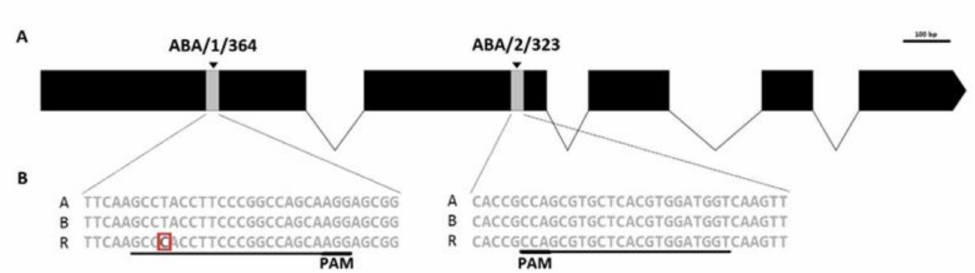
Figure 1. ( A ) Schematic diagram of target ABA8 (cid:48) OH1 regions used for selection of two gRNAs. Black boxes indicate exons, black lines indicate introns, gray boxes represent the regions in exon 1 and exon 2 designated for Cas9/gRNA-induced mutagenesis. ( B ) Detailed sequence context of target motifs (underlined, with PAM indicated) on A, B, and R of triticale sub-genomes. Notably, one SNP is present in the target motif ABA/1/364 of the R